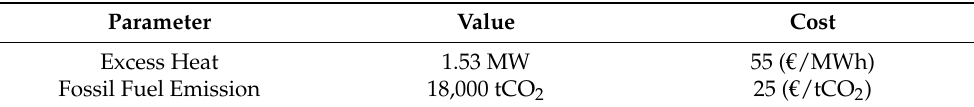
Table 6. Optimal Table 6. Optimal parameters.